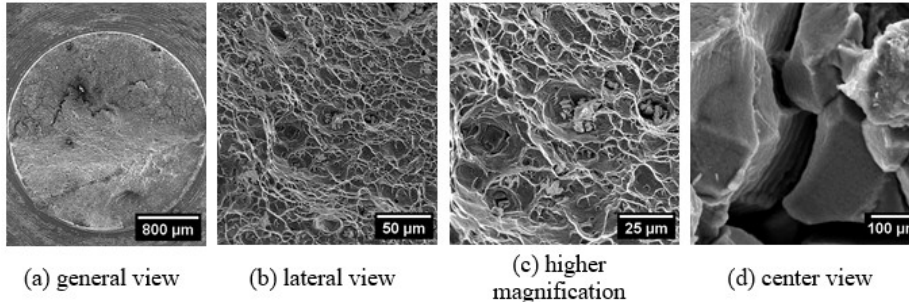
Figure 10. Fracture surface of Inconel 718 after creep test at 650 °C and 700 MPa.